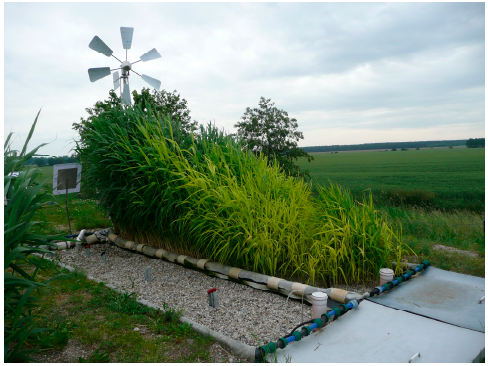
Figure 7. Yellowing and stunted growth of Phragmites australis in an aerated treatment wetland. Water 20XX , X , x FOR PEER REVIEW